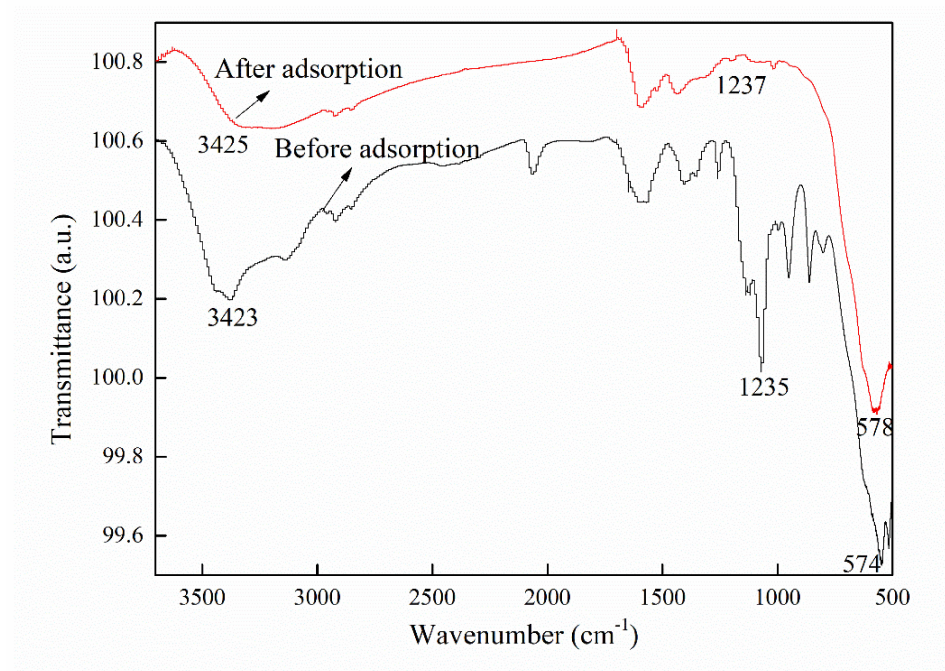
Figure 5. FTIR spectra of CFBs before and after CTC